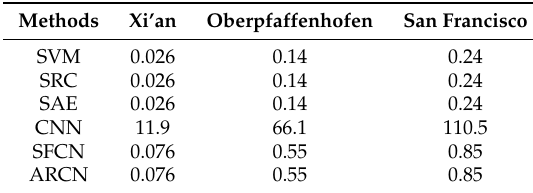
Table 5. Memory consumption of various methods corresponding to three PolSAR Images